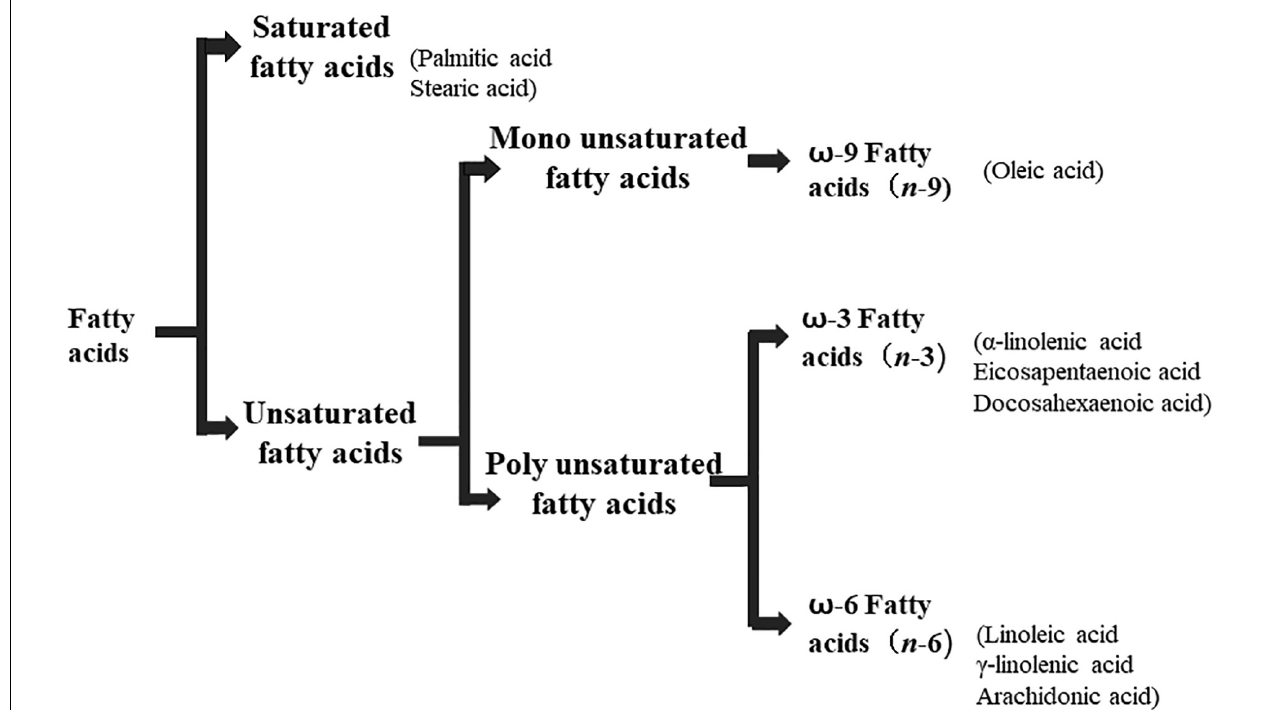
FIGURE 1 | Fatty acid